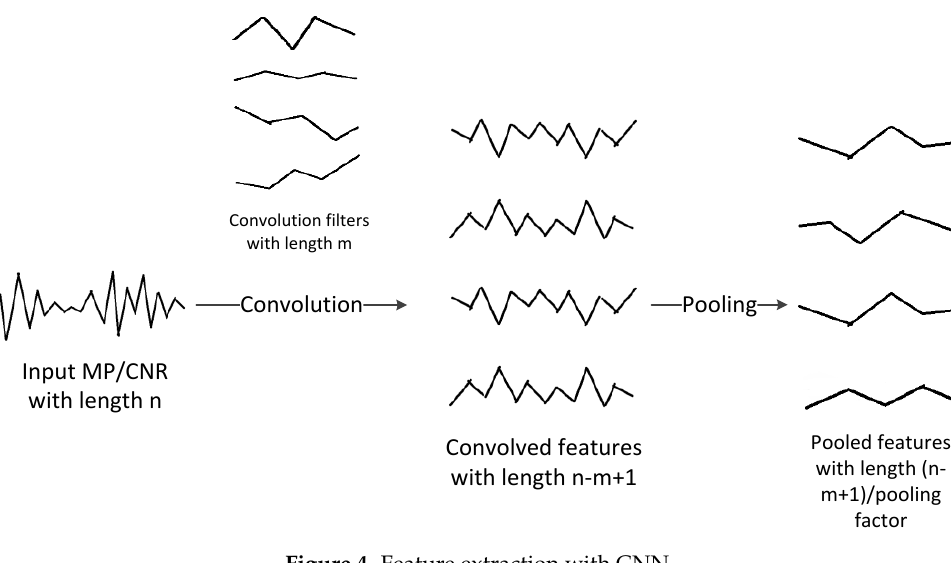
Figure 4. Feature extraction with CNN.